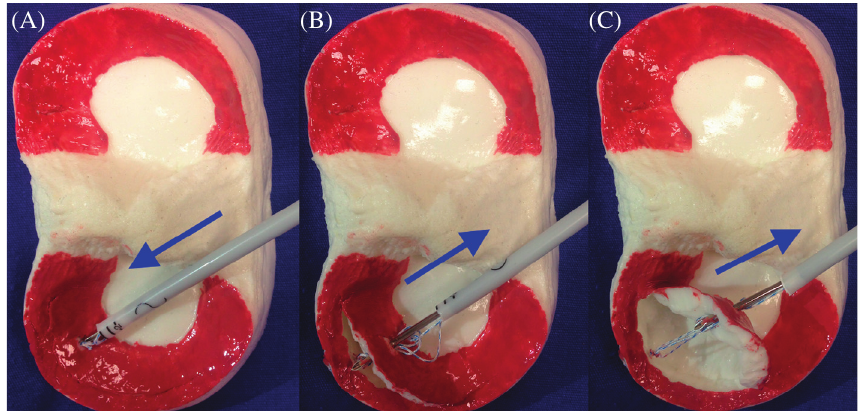
Figure 1. Schematic illustration of the repair of bucket-handle tears with the all-inside method. (A) Insertion of the first suture. (B) Fixation of the first suture on the meniscus as the hand instrument is being removed. (C) The hand instrument causing failure of